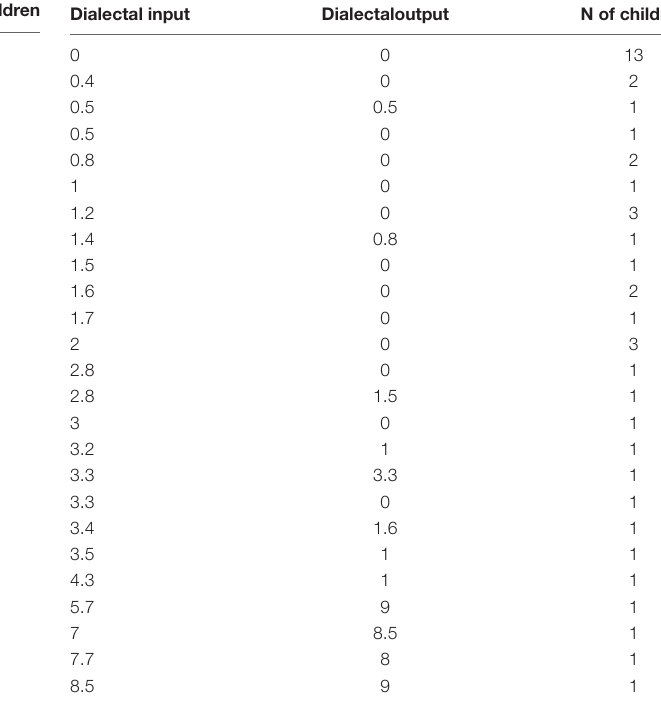
TABLE A | Overview of the linguistic profiles of the children according to children’s input and output in Italian reported in the Italian version of The Questionnaire for Parents of Bilingual Children (Italian version: Dicataldo and Roch, 2020; Levorato and Roch, 2020).